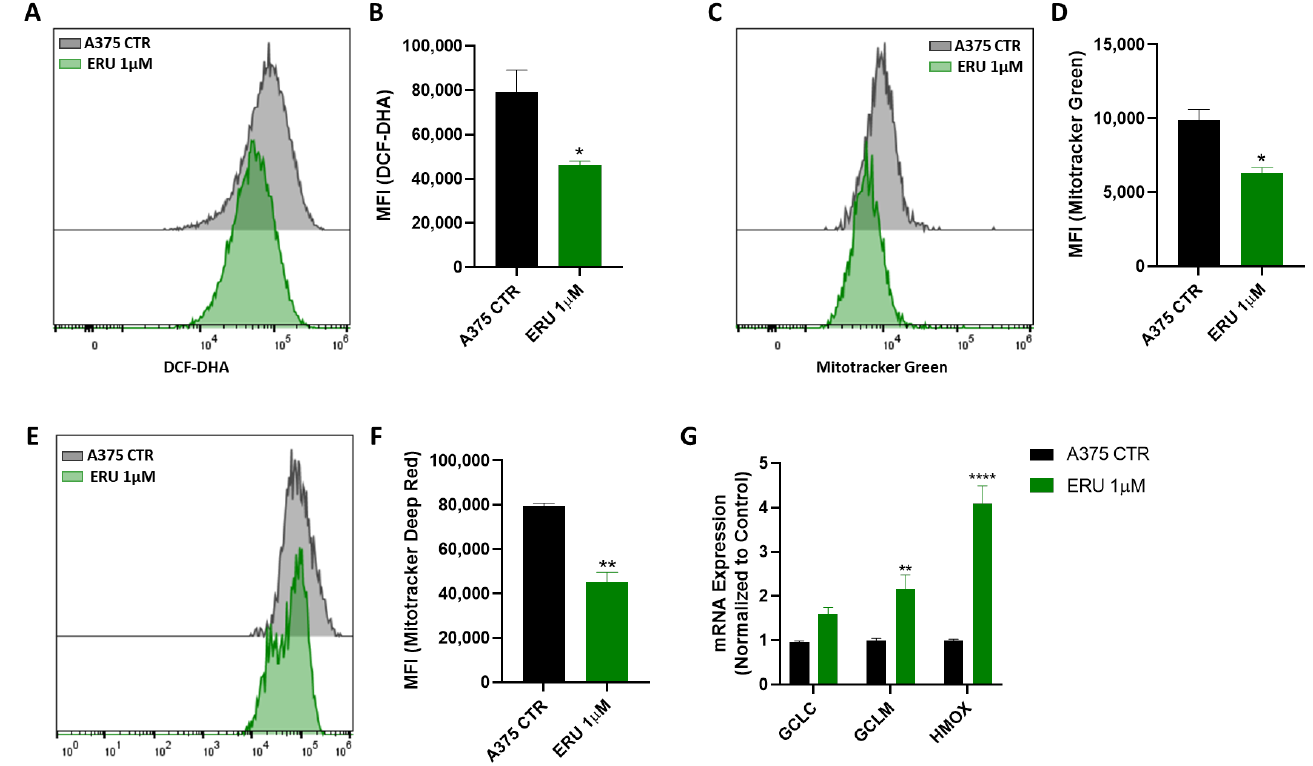
Figure 5. ERU inhibited ROS production in melanoma cells by limiting their mitochondrial function. ( A – F ) Representative examples of flow cytometry analysis of DCF-DHA. ( A ) MitoTracker Green ( C ) and MitoTracker Deep Red staining ( E ) in A375 cells that were untreated (black histograms) and those that underwent ERU treatment (green histograms) for 48 h with their respective quantification in terms of mean fluorescence intensity (MFI) ( B , D , F ). ( G ) Expression of GCLC, GCLM and HMOX assessed with qPCR analysis in A375 melanoma cells that were treated (green bar) or not treated